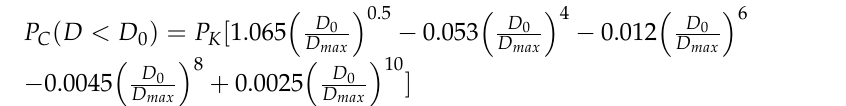
Table 2. Particle size distribution and content of aggregate in concrete.